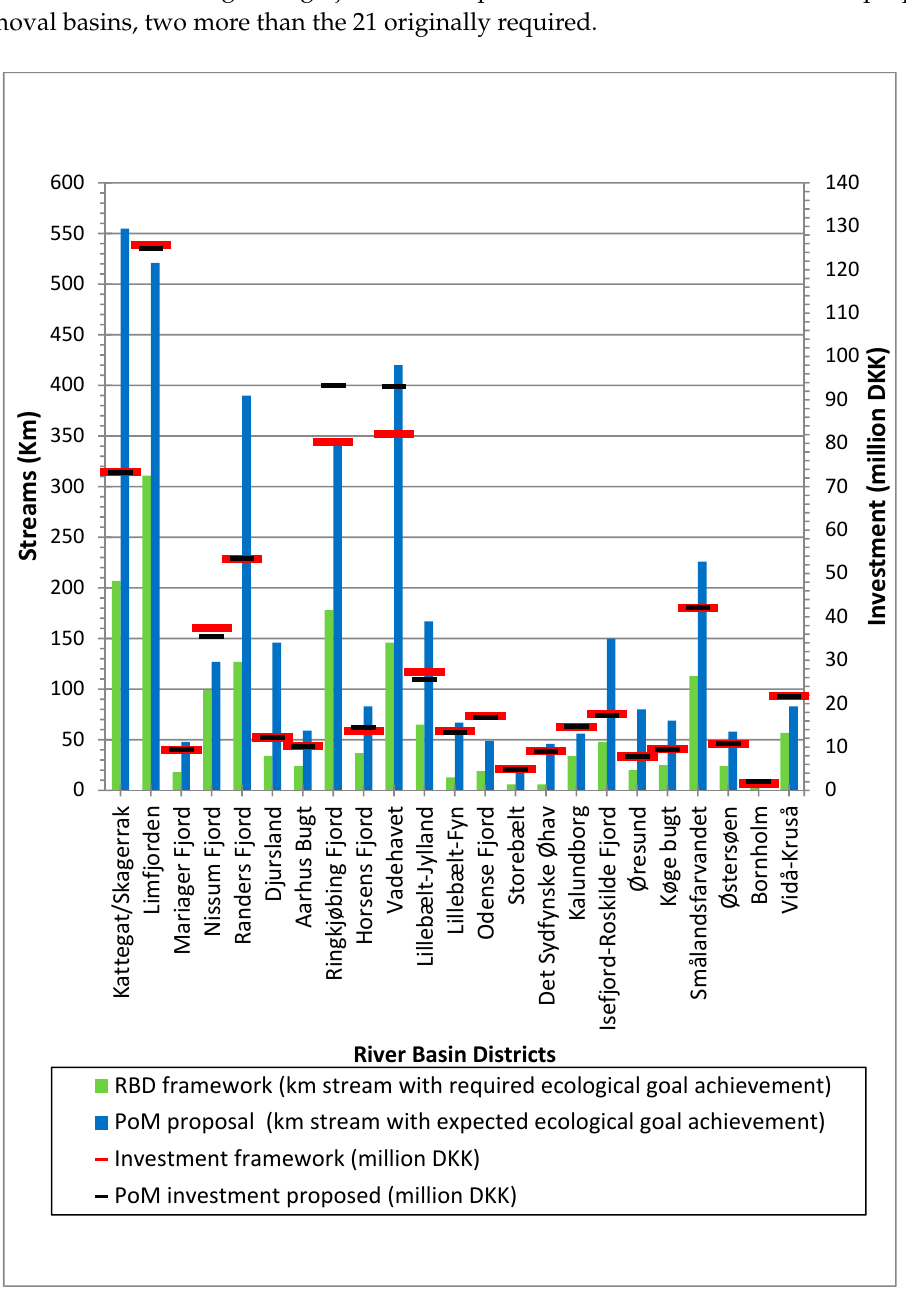
Figure 2. Comparisons of two outputs: (1) the RBD framework requirements relative to the water councils/municipalities’ proposals (km stream, blue and green bars); and (2) the investment framework given to the water councils relative to the investments proposed in the RBMPs 2015–2021 (million DKK, red and grey symbols).